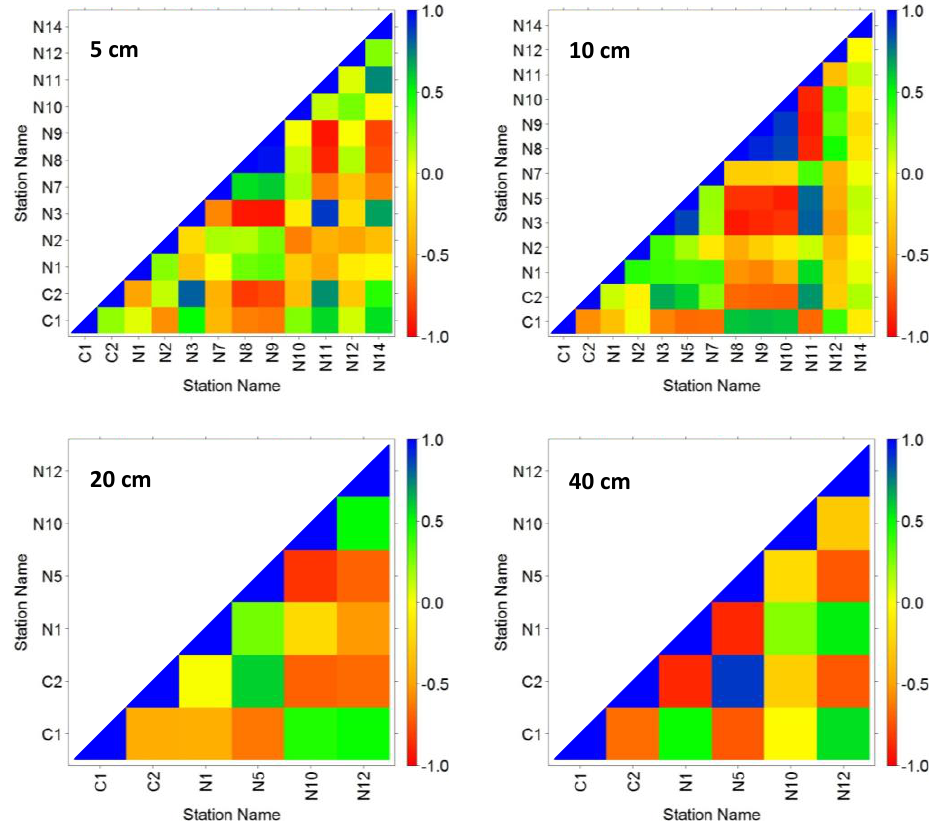
Figure 5. Triangular matrix of Pearson correlation coefficient [Equation (6)] between stations at respective probe depth (day 1 is January 1st,